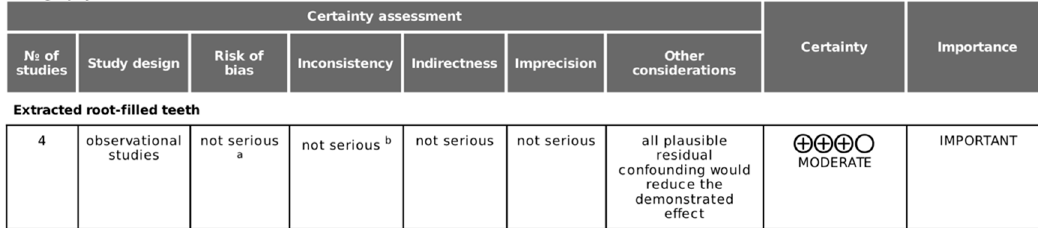
Figure 4. GRADE Working Group grades of evidence: Smoking habits and the prevalence of radiolucent periapical lesions in root-filled teeth. Explanations: a. Detailed in Figure 5: Risk of bias summary, b. I 2 = 0%. High certainty: the authors have a lot of confidence that the true e ff ect is similar to the estimated e ff ect. Moderate certainty: the authors believe that the true e ff ect is probably close to the estimated e ff ect. Low certainty: the true e ff ect might be markedly di ff erent from the estimated e ff ect. Very low certainty: the true e ff ect is probably markedly di ff erent from the estimated e ff ect.